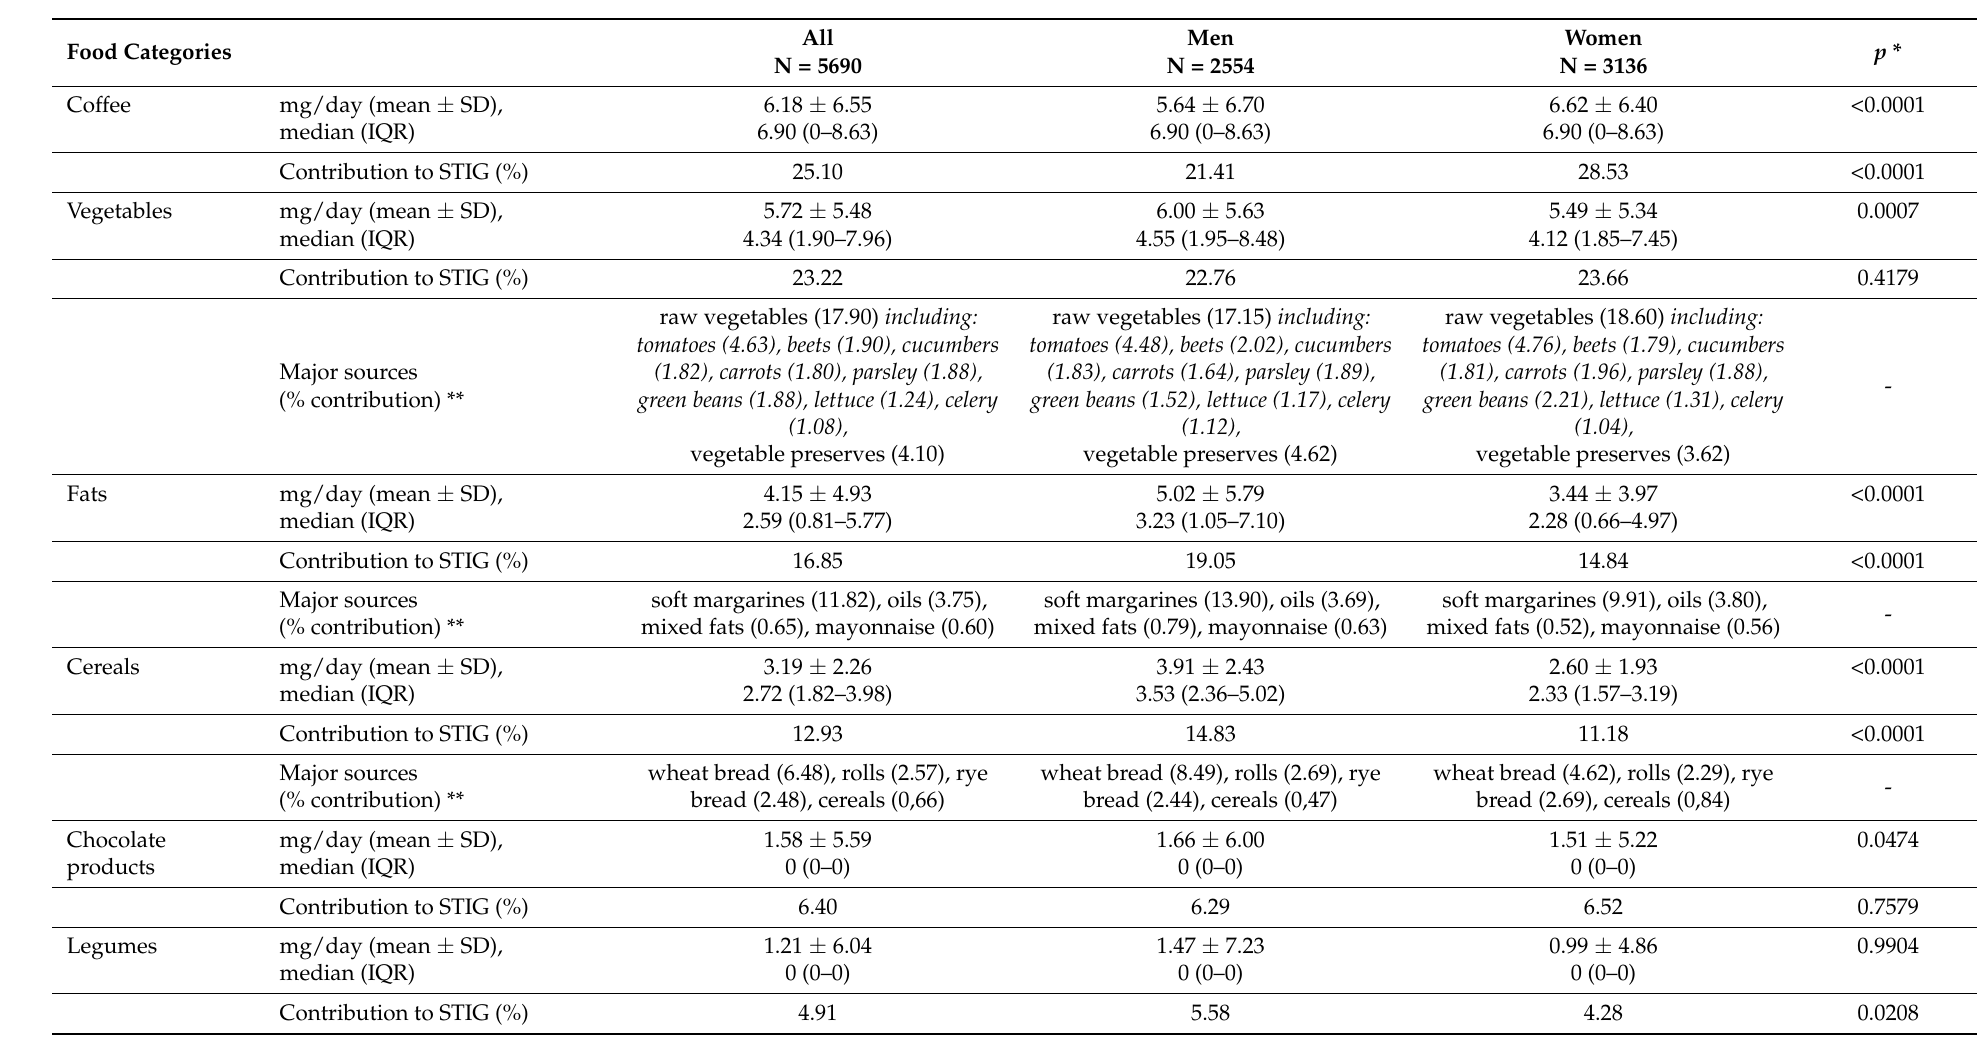
Table 5. Contributions of food categories and individual food products to stigmasterol intake (STIG), listed according to diminishing order of